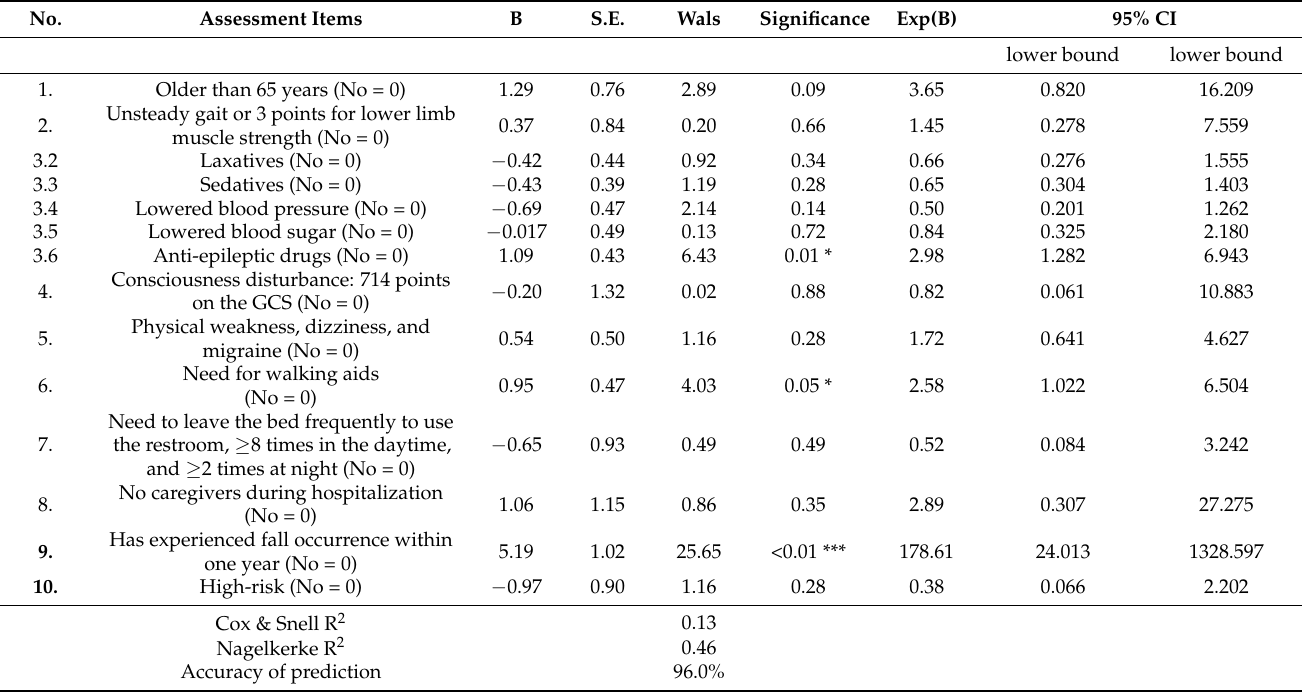
Figure 2. ROC curve analysis results of psychiatric patients. Table 3. Logit model of psychiatric